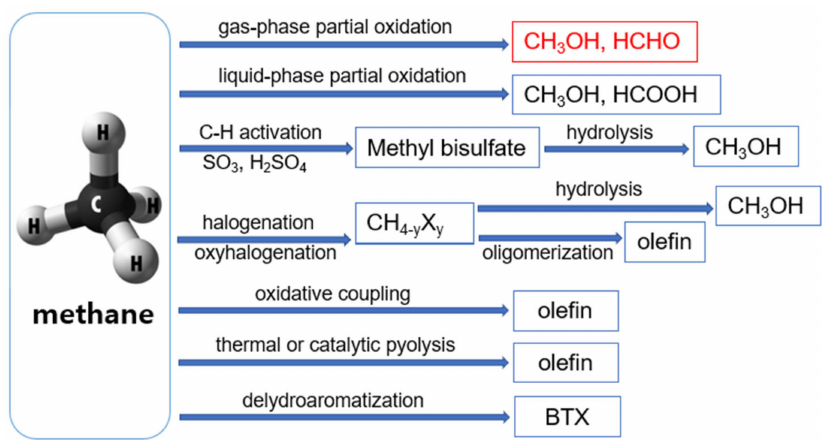
Figure 1. Various routes in the direct conversion of methane technologies.